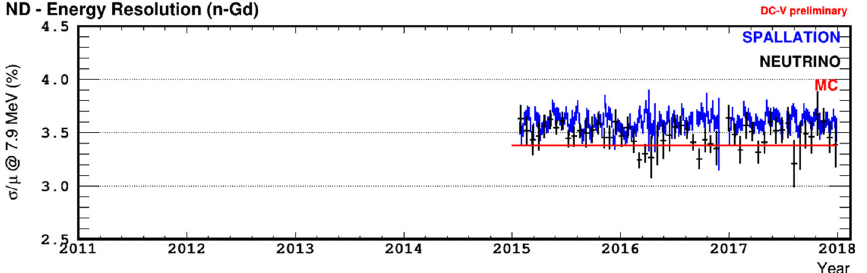
Fig. 29 Stability of energy resolution at about 8MeV (Gd-peak) in the Double Chooz near detector over the 3 years of data taking. The blue data points correspond to the capture of spallation neutrons, the black